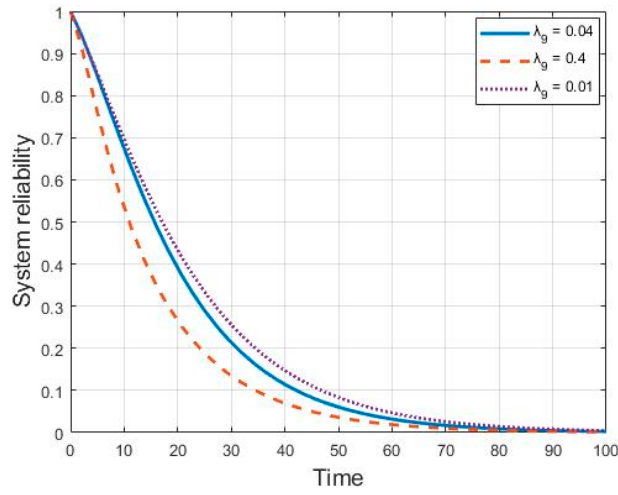
Figure 8. System reliability comparison with the changes of failure rate λ 9 .